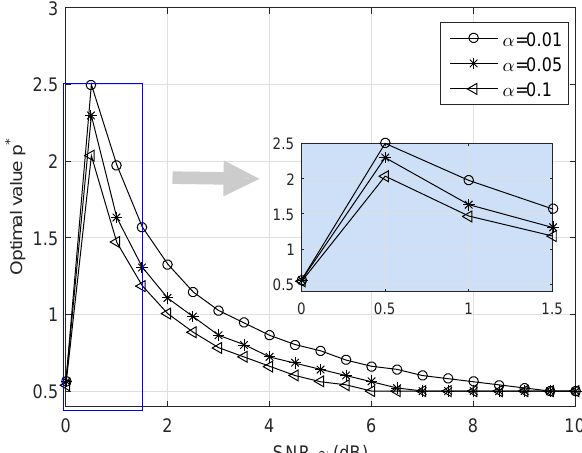
Figure 2. Illustration of CDFs under H 0 and H 1 . Note that the theoretical analysis shows that the Γ ( k ) under H test statistic t i , θ i i , while the simulation approximation gives us t ∼ N ∼ where E ( t ) and Var ( t ) are given in (14) and (15), respectively. ( a ) Simulated CDFs for t under H 0 when γ = 0. ( b ) Simulated CDFs for t under H 1 when γ = 0.